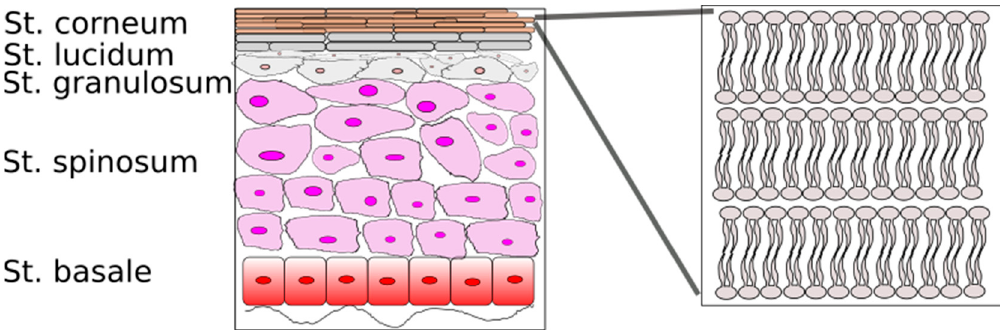
Figure 1. Structure of the epidermis and the intercellular lipid matrix.